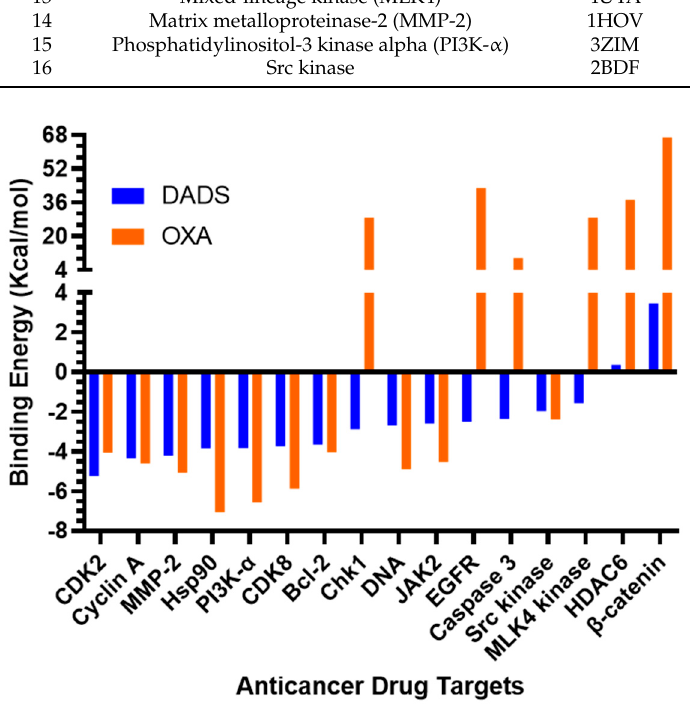
Figure 1. A bar plot of molecular docking-predicted binding energy in kcal/mol and several anti- cancer drug targets for DADS and OXA.